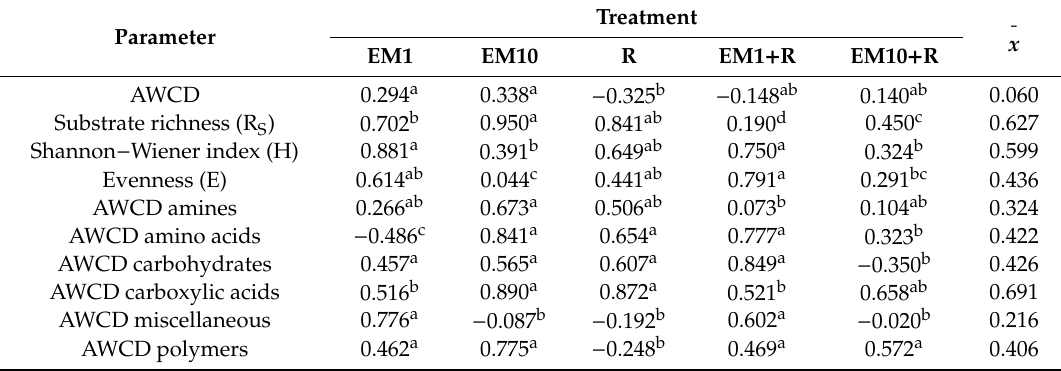
Table 8. Values of the resilience (RL) index for measured parameters obtained at the end of the